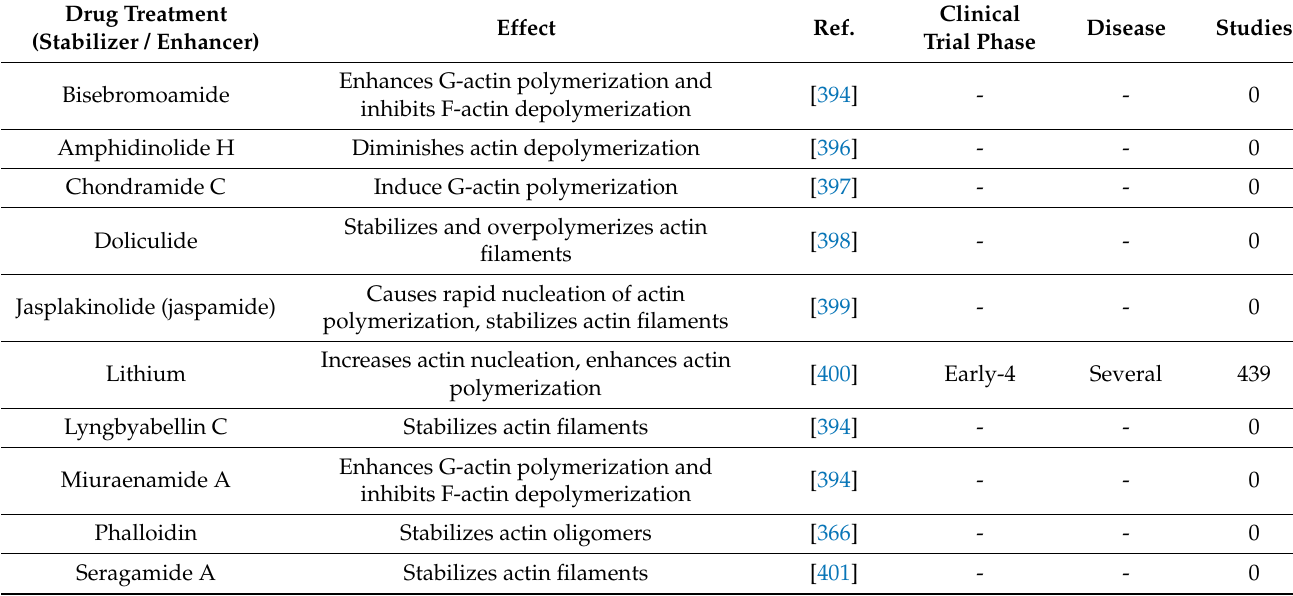
Table 3. The effects of stabilizer or enhancer on the actin cytoskeleton and information on tests in clinical trials. The cited references describe the effect on actin; information on clinical trials was collected from clinicaltrials.gov (accessed on 27 January